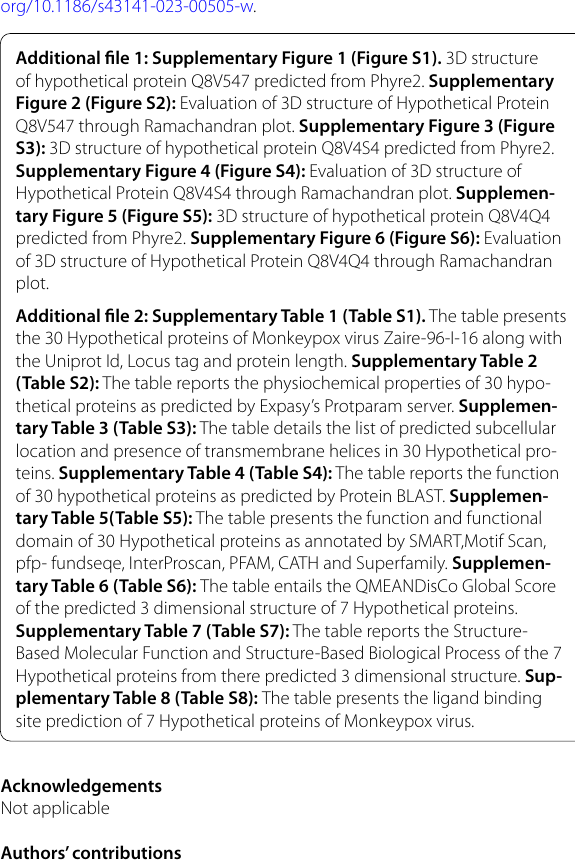
tary Table 6 (Table S6): The table entails the QMEANDisCo Global Score of the predicted 3 dimensional structure of 7 Hypothetical proteins. Supplementary Table 7 (Table S7): The table reports the Structure- Based Molecular Function and Structure-Based Biological Process of the 7 Hypothetical proteins from there predicted 3 dimensional structure. Sup- plementary Table 8 (Table S8): The table presents the ligand binding site prediction of 7 Hypothetical proteins of Monkeypox